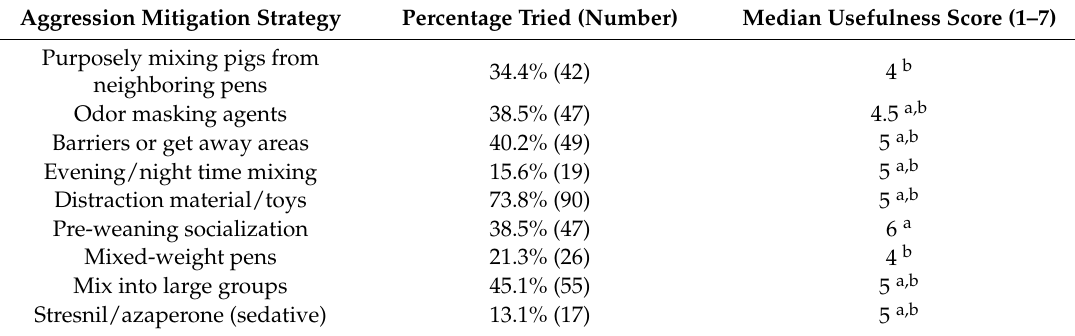
Table 3. Percentage of respondents who had tried each aggression mitigation strategy and the median usefulness score for each strategy (from 1 = not useful at all to 7 = very useful). Different letters indicate significantly different usefulness scores at p <